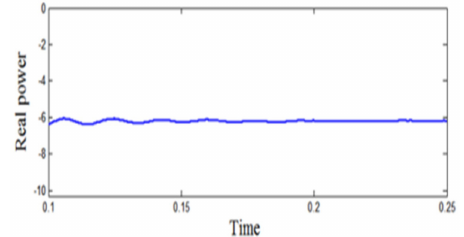
Figure 32. Reactive power demand from the load side.